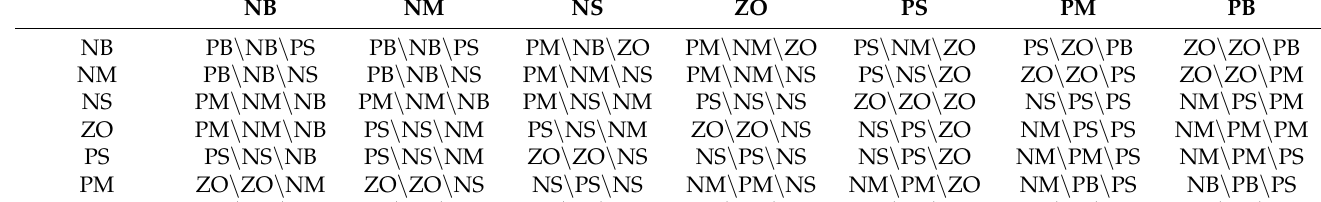
Table 2. Fuzzy inference rules table.